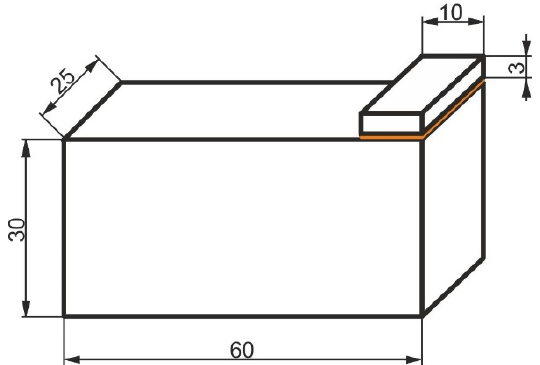
Figure 1. Dimensions of a block specimen (mm).